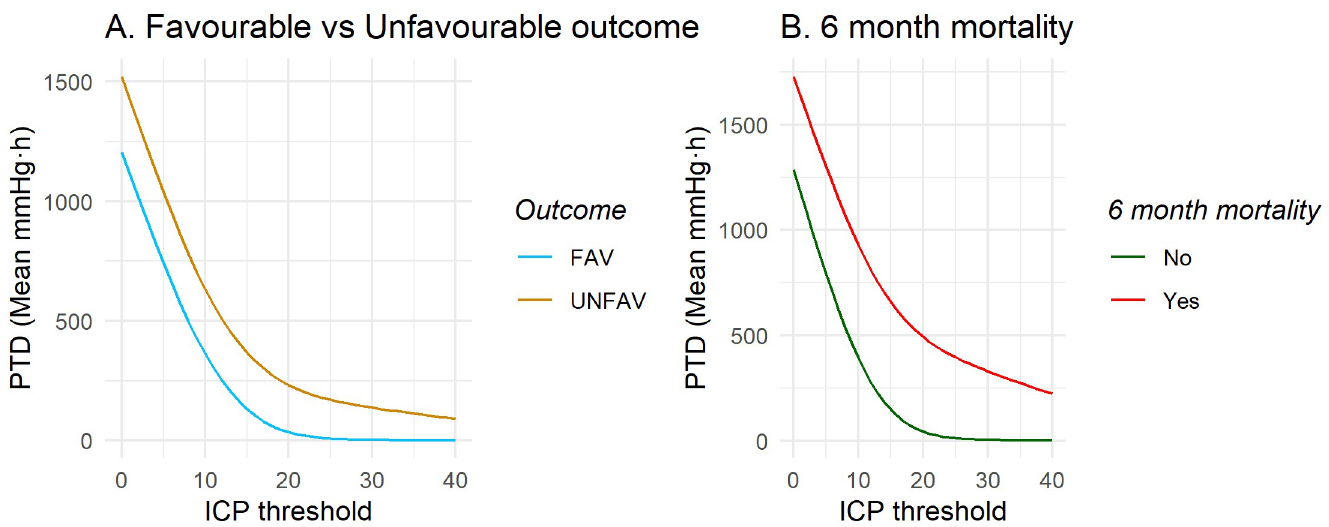
Fig 7. Group mean PTD (mmHg � h) above thresholds of ICP, median for A) favourable vs unfavourable outcome, B) dead vs alive at 6 months post injury.